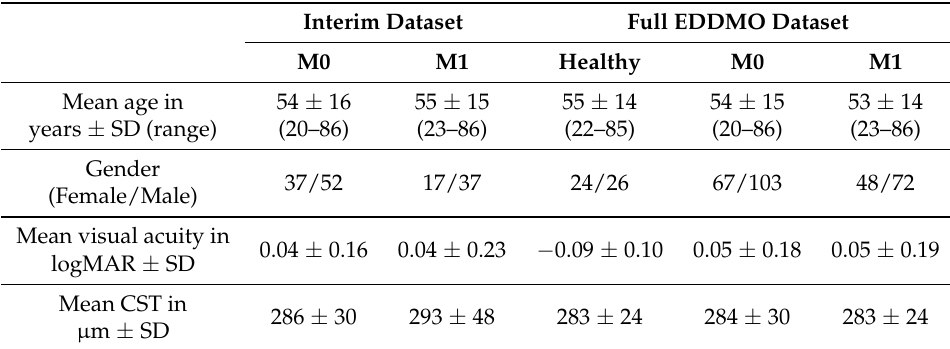
Table 3. Summary of the demographics and clinical data of the participants used for the analysis